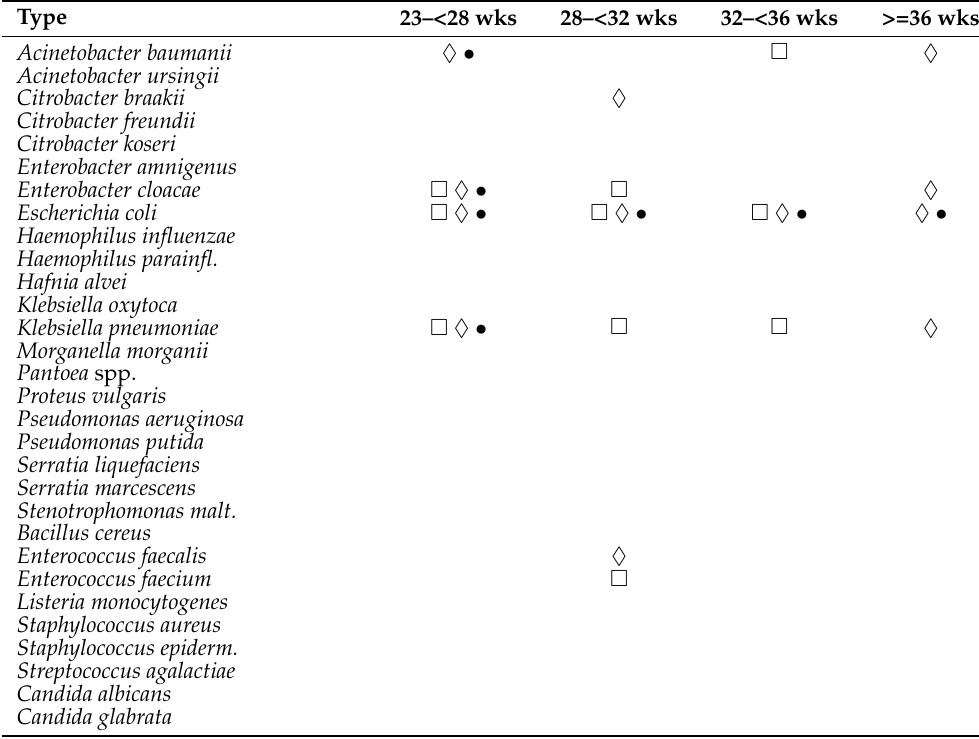
Table 3. Types of organisms isolated from rectal swabs. (cid:3) Isolated from infants without sepsis. ♦ Isolated from infants with clinical sepsis. • Isolated from infants with blood-culture-proven